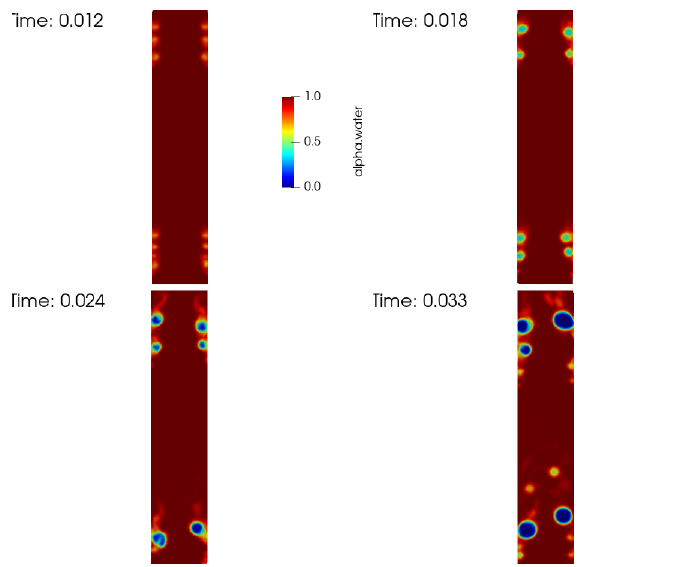
Figure 10. The distribution of ethanol volume fraction (alpha.water) in the evaporator area for the first milliseconds of simulation in the Xu et al. [29] mass transport model for the case of 100 W input power.